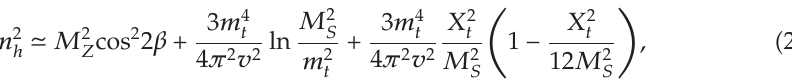
Figure 2: Same as Figure 1, but only for the NMSSM, showing the correlation between m (cid:4) m (cid:4) /m (cid:4) t 2 t 1